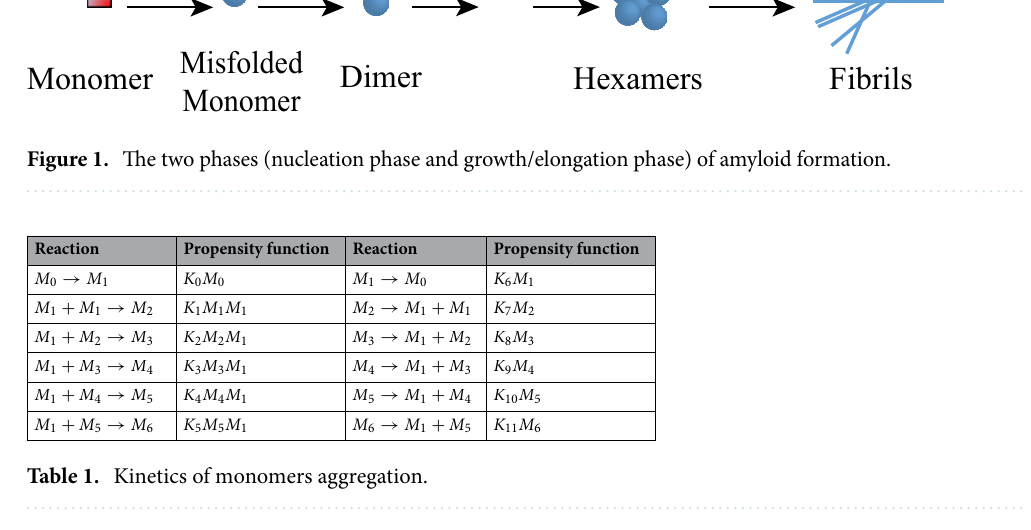
Table 1. Kinetics of monomers aggregation.